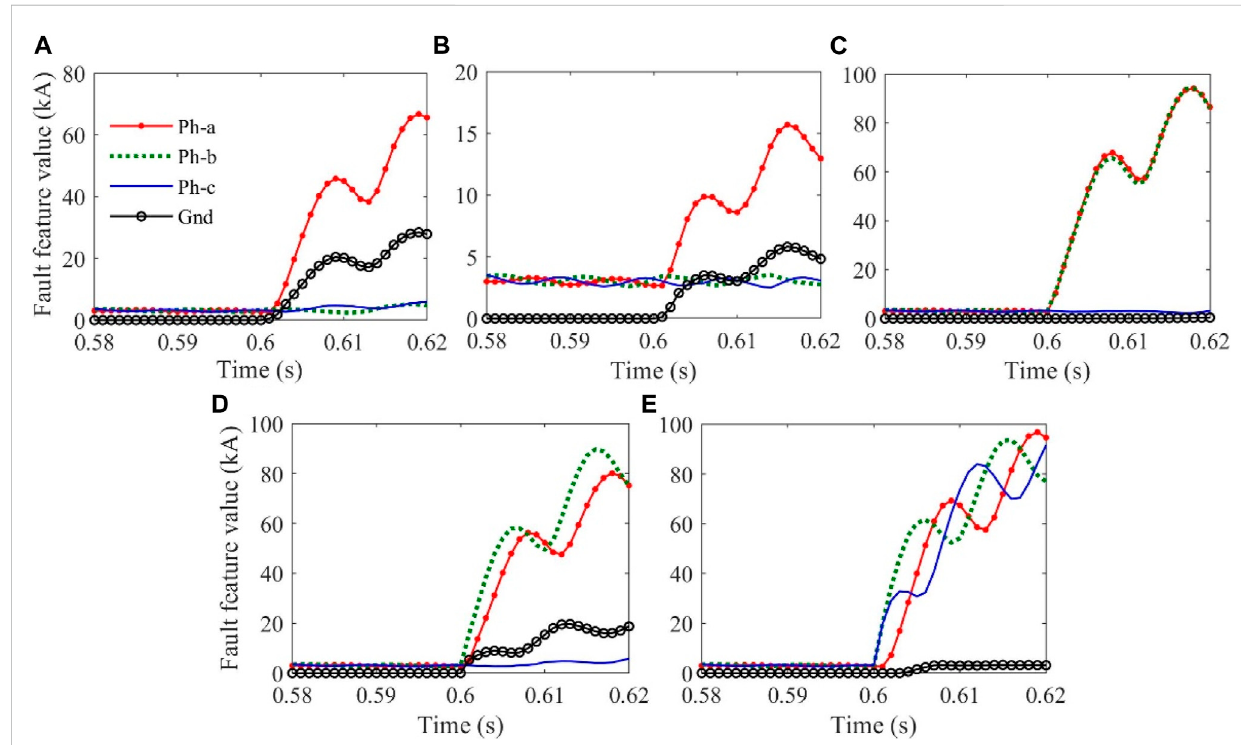
FIGURE 11 Demonstration of the variation of input fault features β to the BE classi fi er for few typical fault cases initiated at 0.6 s (60 km away from the grid side of Figure 1 with CL = 40%): (A) ag-fault ( R f = 10 Ω ), (B) ag-fault ( R f = 200 Ω ), (C) ab-fault, (D) abg-fault ( R f = 10 Ω ), and (E) abc-fault.